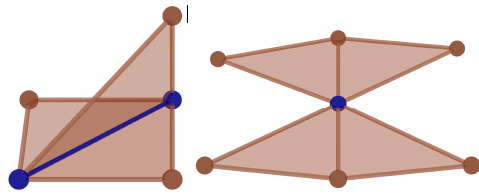
Figure 9. The example of non-2-manifold mesh (two surface sheets meet at a non-manifold vertex ( right ). A non-manifold edge has more than two incident faces ( left ))